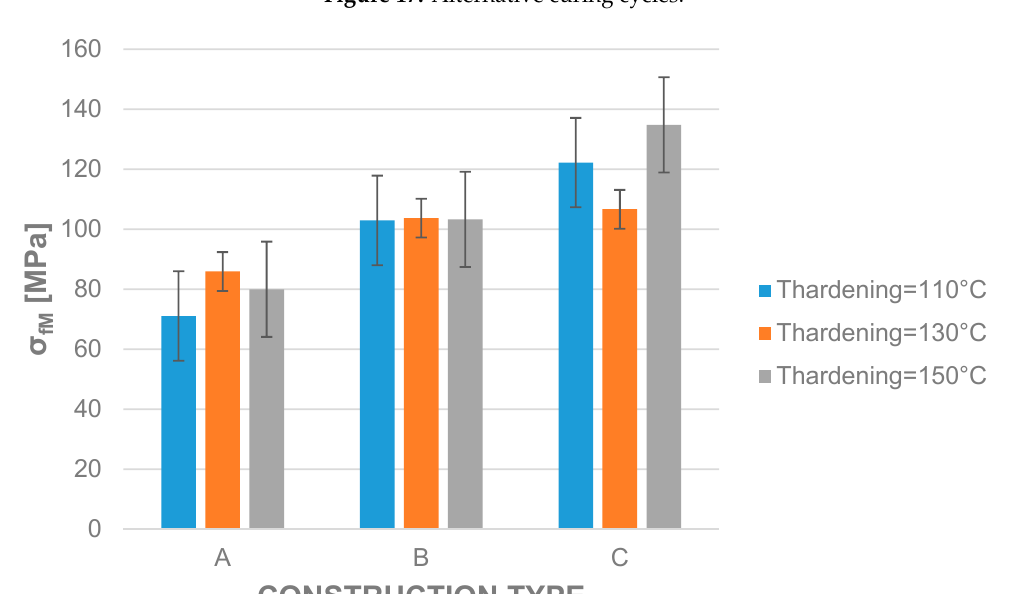
Figure 17. Alternative curing cycles.